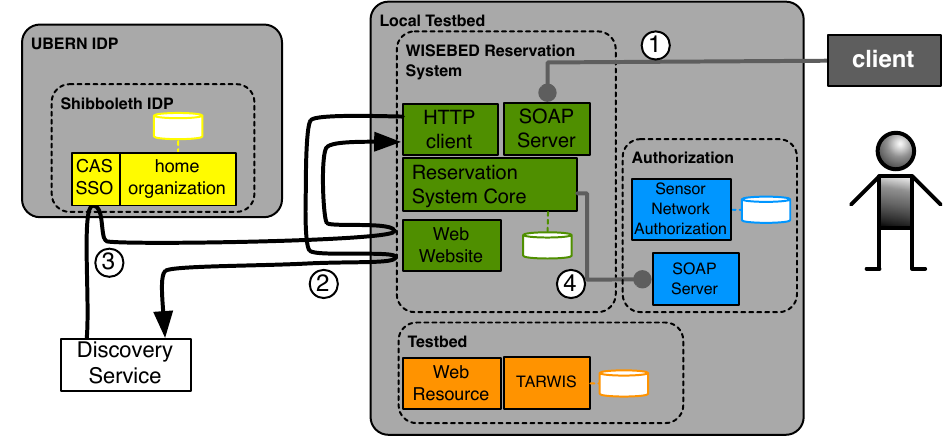
Figure 8. Example: Authentication and authorization for